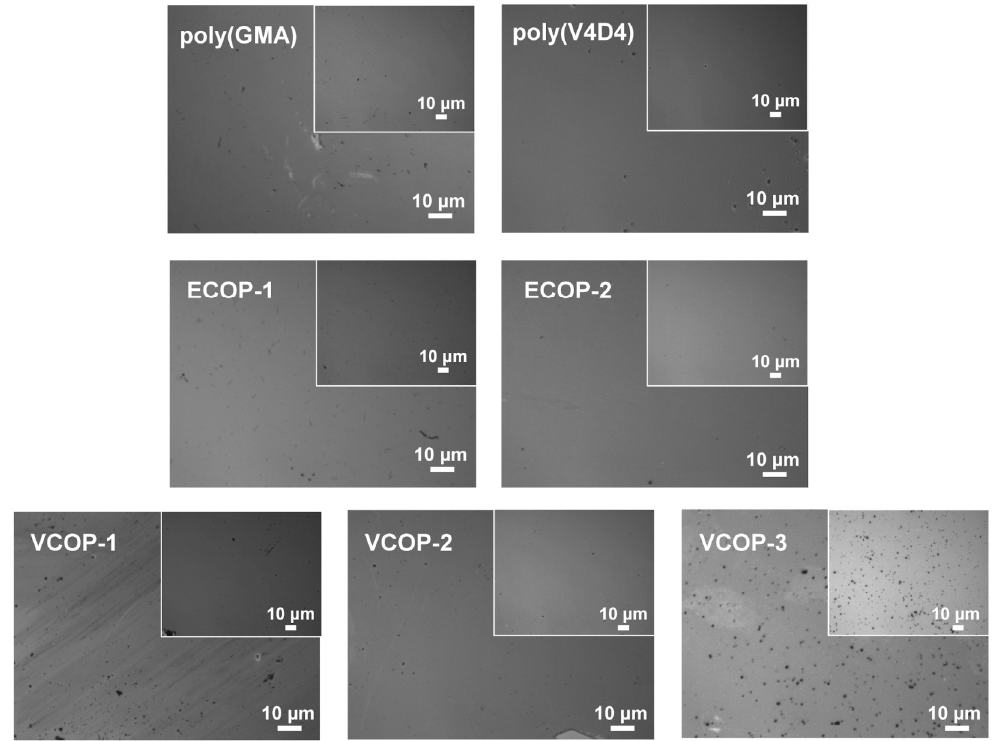
Figure 12. Optical microscopy images of homo and cross-linked copolymer films before (inset) and after (onset) adhesion test.